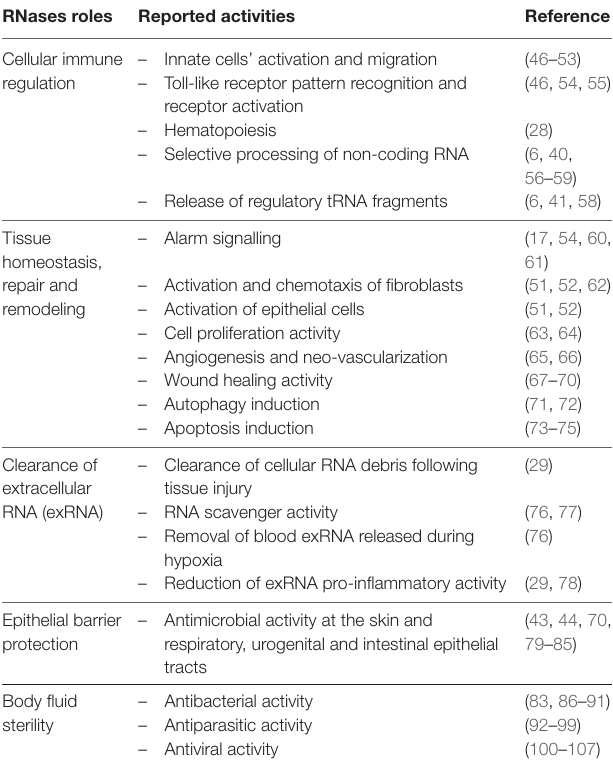
TABLe 1 | Proposed roles and reported activities for extracellular